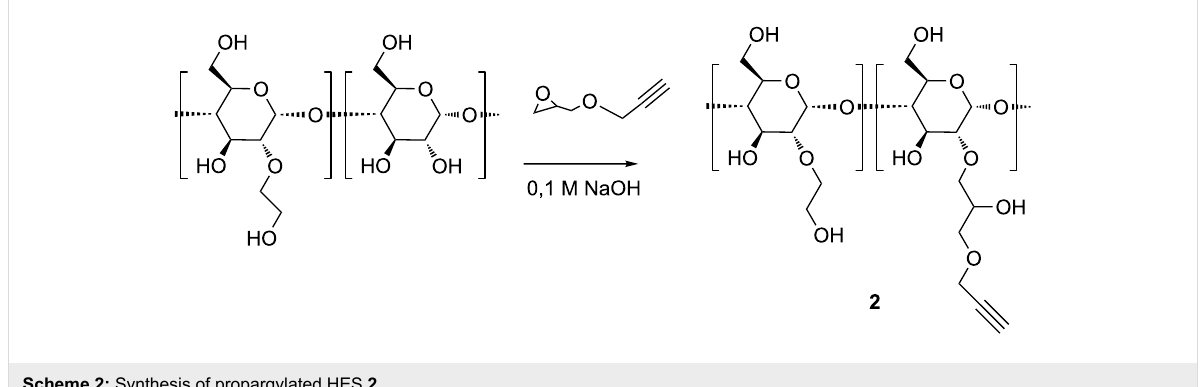
left, which is equivalent to a DS CD (methyl) = 2.2. The signals at 3.66 ppm and 3.43 ppm were assigned to the methyl groups in O-2 and O-6 position, respectively [40]. Nearly no signal was found corresponding to methyl groups in O-3 position. If the according methylation was instead performed with NaOH as the base it proceeded much faster and with a high chance of over- methylation. Careful control of the reaction time lead to another product 1b with a similar degree of methylation DS CD (methyl) = 2.3, but a much higher structural hetero- geneity as demonstrated by the 1 H NMR spectrum (Figure 3s, Supporting Information File 2) which was much less resolved than the spectrum of 1a (Figure 2a). Methylations